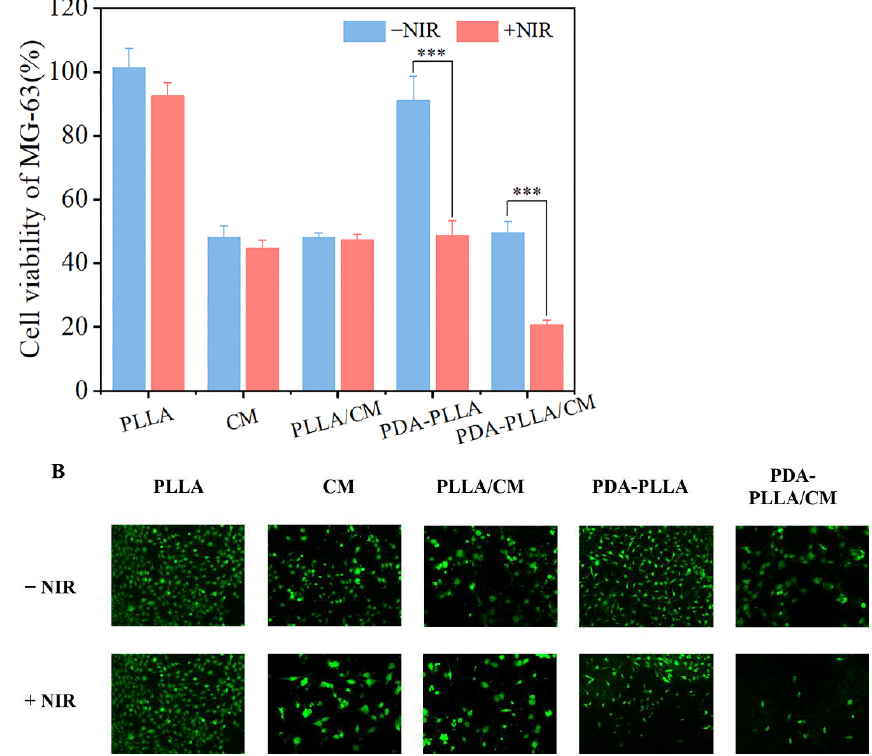
Figure 6. ( A ) Cell viability ofMG-63 cells after being cultured with PLLA, PLLA/CM, PDA-PLLA and PDA-PLLA/CM microparticles at the same CM concentration level with or without NIR irradiation (PLLA, PLLA/CM, PDA-PLLA and PDA-PLLA/CM microparticles, 500 µ g/mL; CM, 75 µ g/mL). ( B ) Fluorescence staining images of MG-63 cells with or without NIR irradiation (1.3 W/cm 2 ) for 10 min. (*** p -value < 0.001).